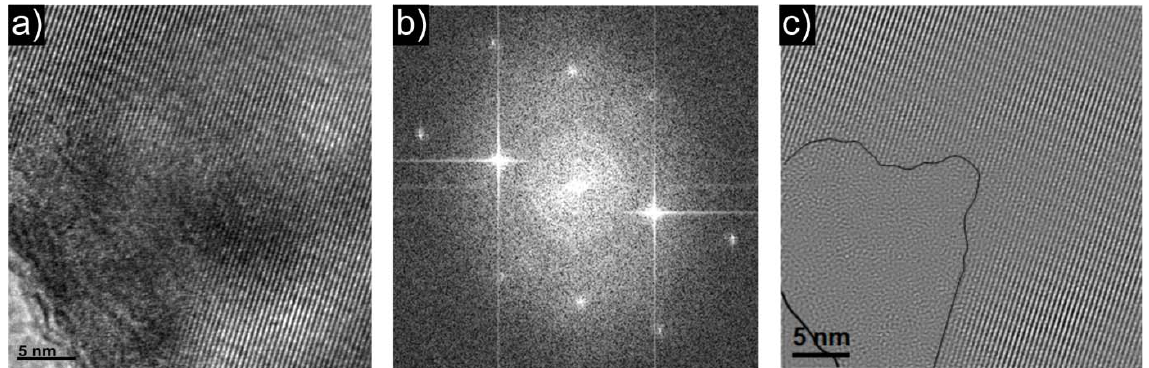
Al FePO 0.97 0.01 4